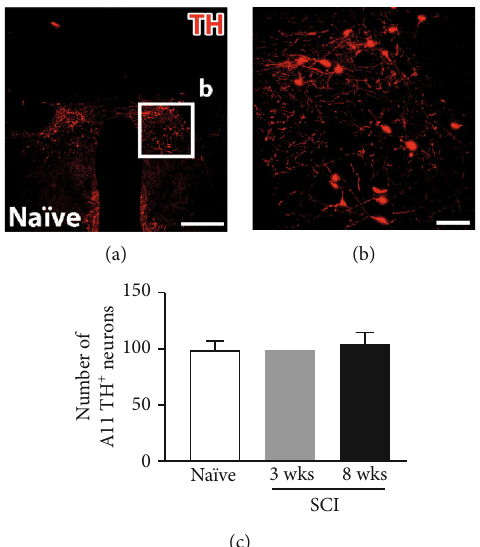
Figure 4: Quantitative analysis of A11 neurons between naïve and SCI rats. (a, b) A representative image illustrating the distribution of TH + (red) neurons and their projections in the A11 region of naïve rats. (c) Quantitative analysis shows no signi fi cant di ff erence in the number of TH + neurons after SCI-induced axotomy vs. intact rats. (b) is boxed regions in (a). Scale bars: (a) 500 μ m; (b) 100 μ m.